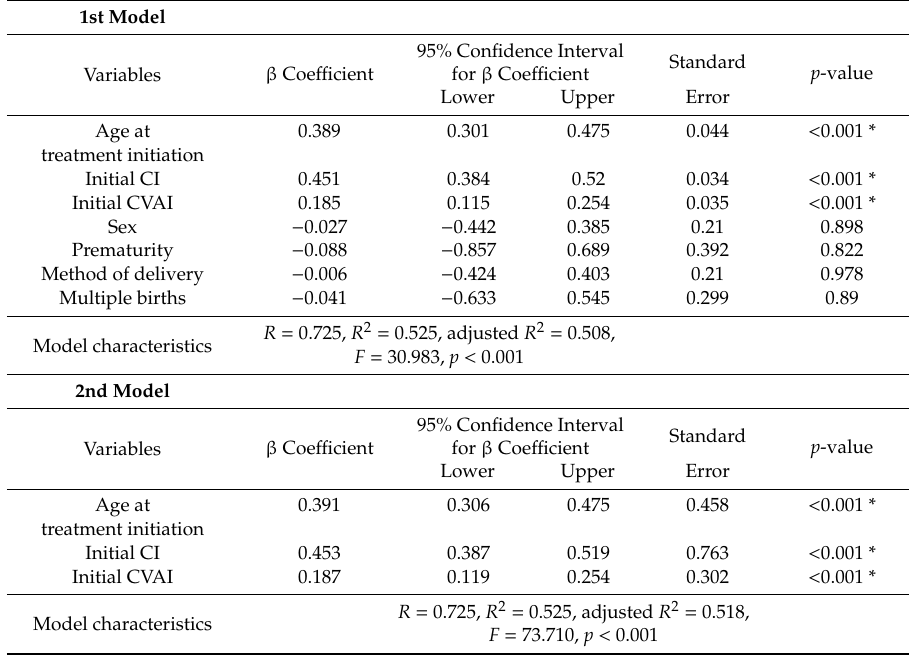
Table 4. Multiple linear regression analysis of factors potentially associated with treatment duration in patients with a CI < 90% ( N = 204).